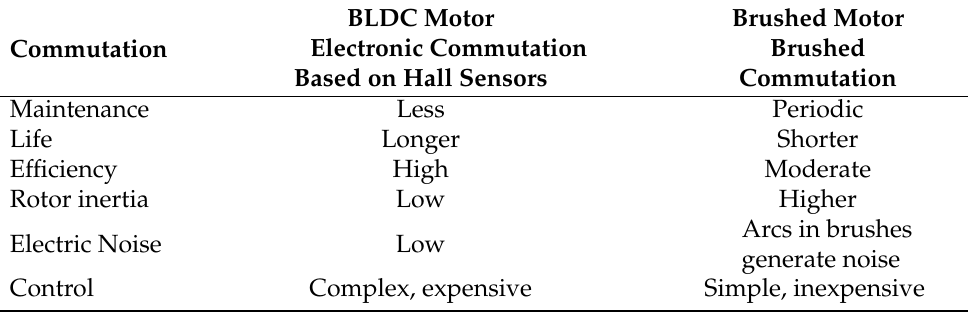
Table 6. Quality Characteristics of Brushless and Brushed Motors.